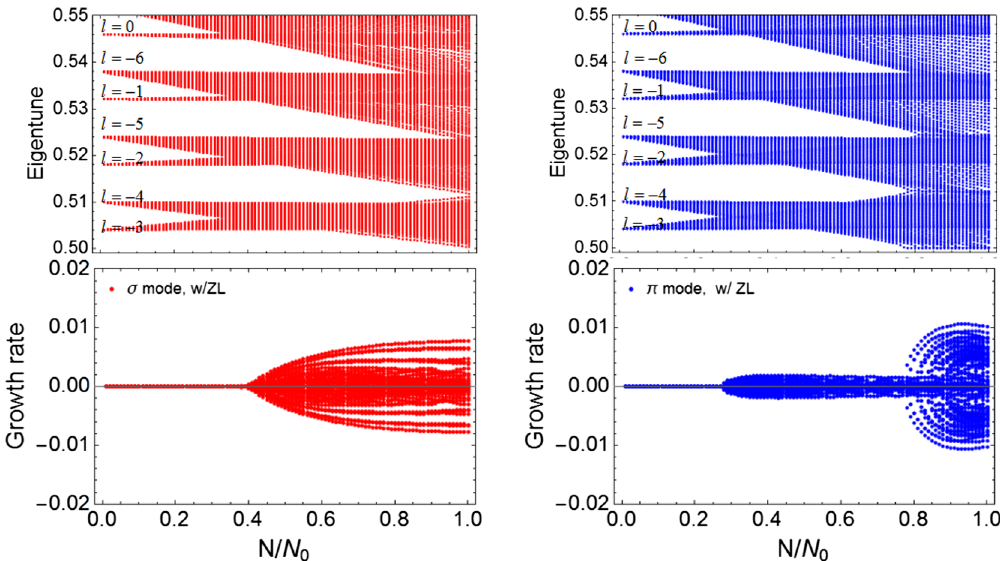
FIG. 12. Eigenvalues of the σ mode (left) and π mode (right) as a function of bunch population with longitudinal impedance (ZL), ¼ 0 . 546 where ν x